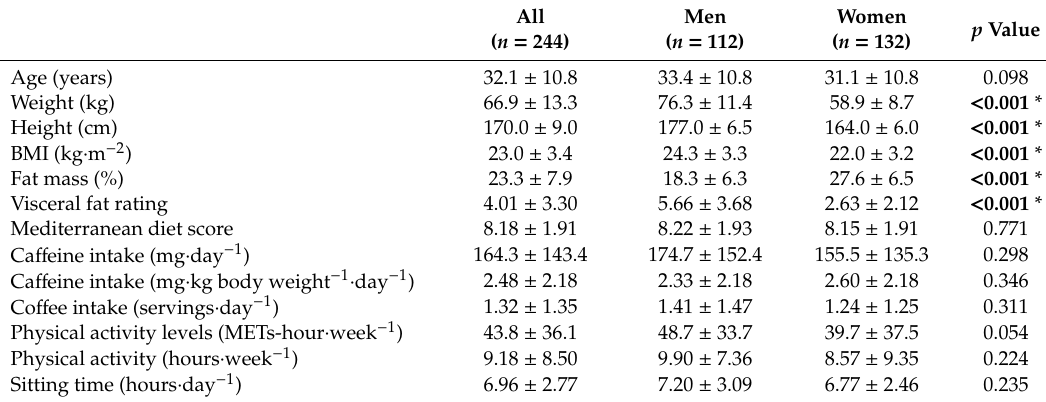
Table 1. General characteristics of participants in the study.